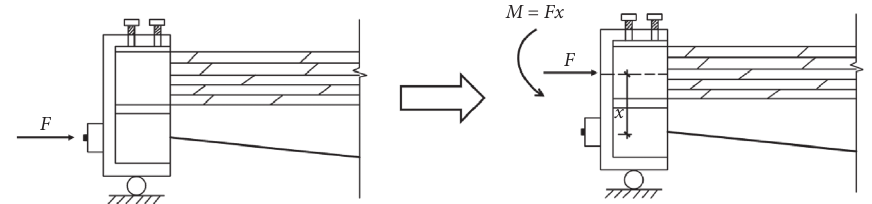
Figure 3: Interaction between steel wire and glued laminated timber.